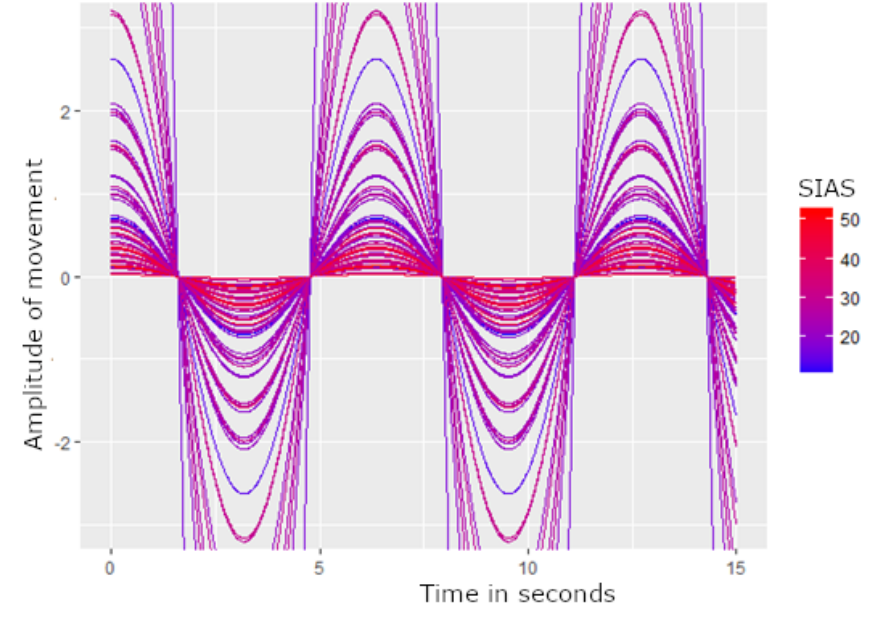
Figure 4. Oscillations of movement at approximately every 6 seconds and the relationship to social anxiety symptom severity. Note that each line represents a separate person. The lines are shaded from blue (low social anxiety symptoms) to red (high social anxiety symptoms). This graph clearly depicts that those with high social anxiety symptoms tended to have lower amplitudes of these 6-second oscillations than those with higher social anxiety symptoms. SIAS: social interaction anxiety